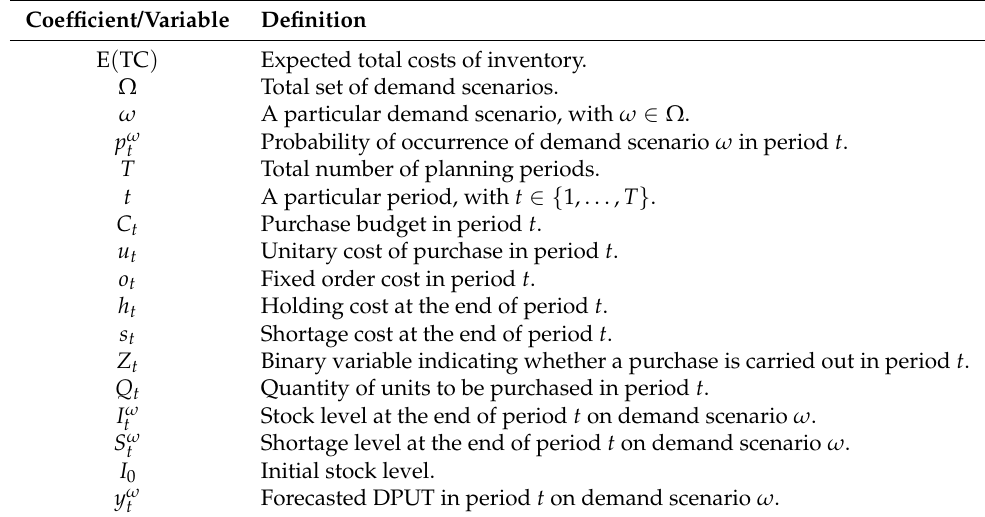
Table 2. Definition of coefficients/variables of the optimization model.